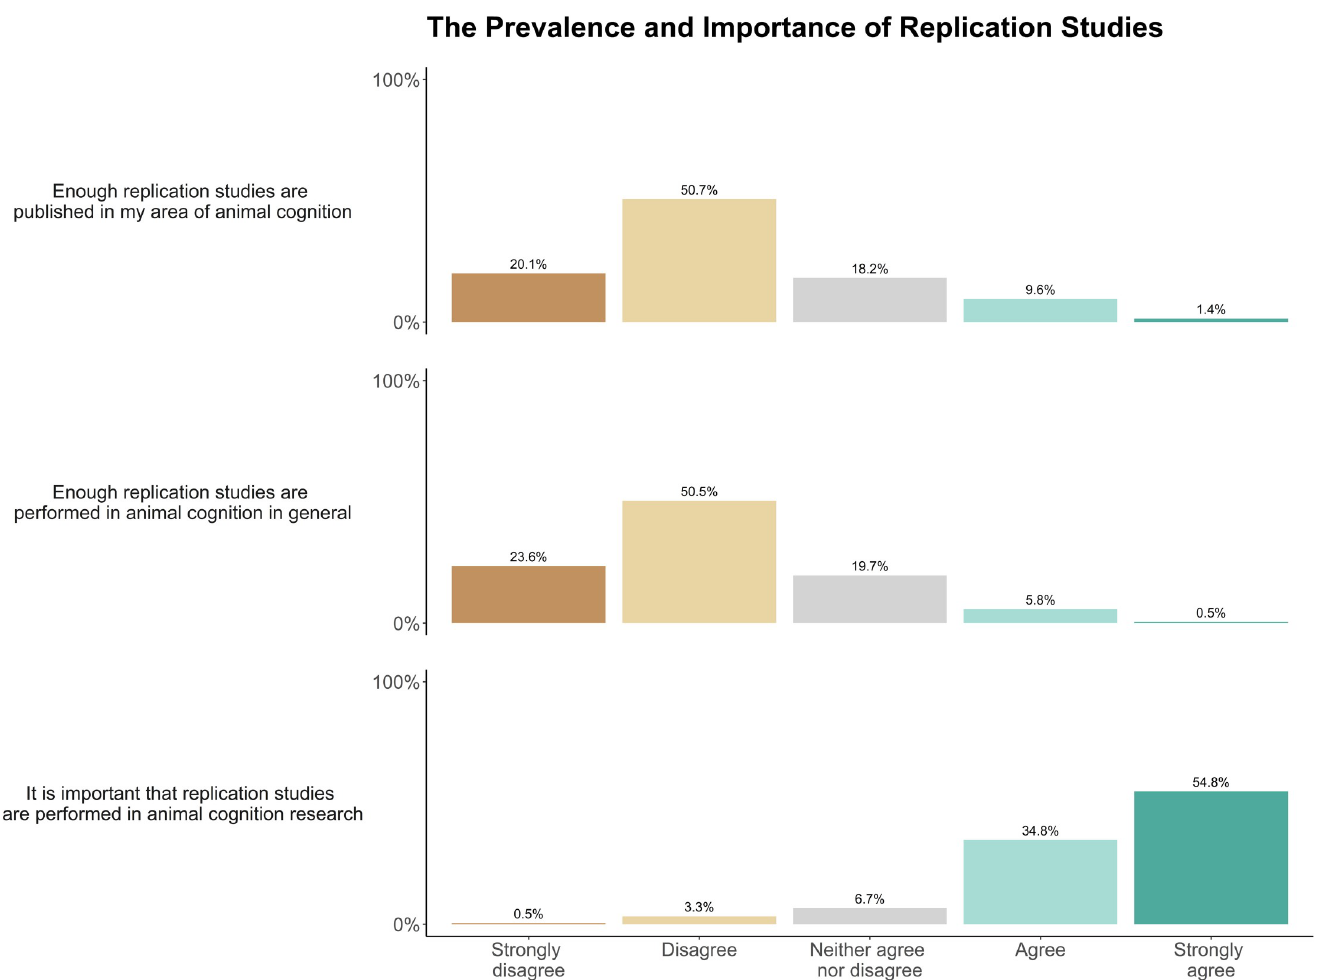
Fig 15. Animal cognition researchers’ perceptions of the frequency and importance of replication studies in the discipline, N =